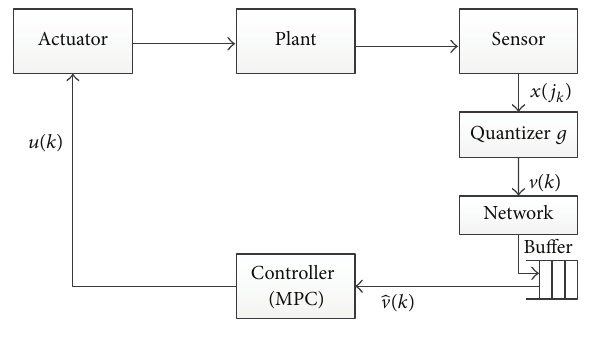
Figure 1: Structure of